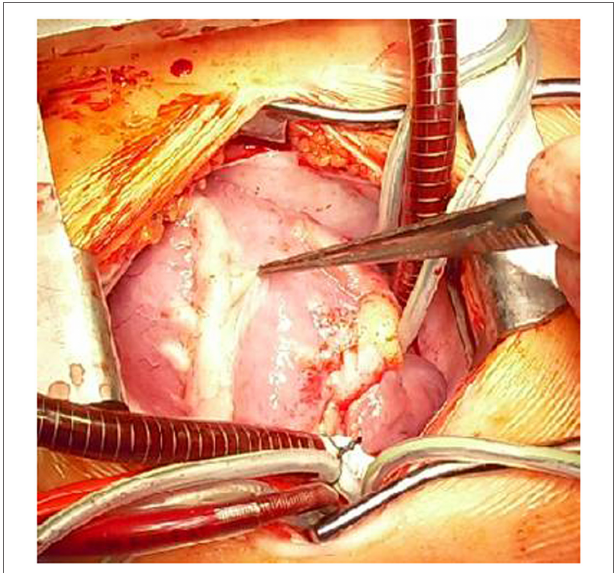
FIGURe 3 | Intra-operative view of the diseased heart with the extensive changes of the coronary arteries caused by Kawasaki disease . In front is the left anterior descending artery